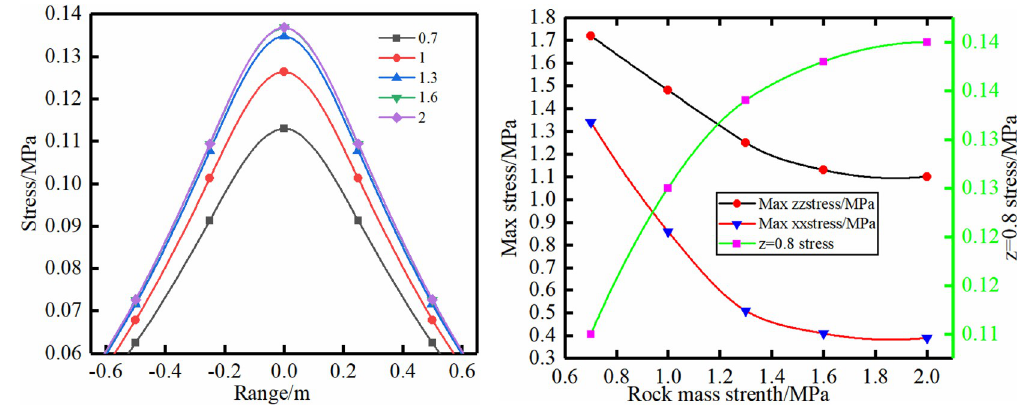
Fig 5. Different rock mass strength.